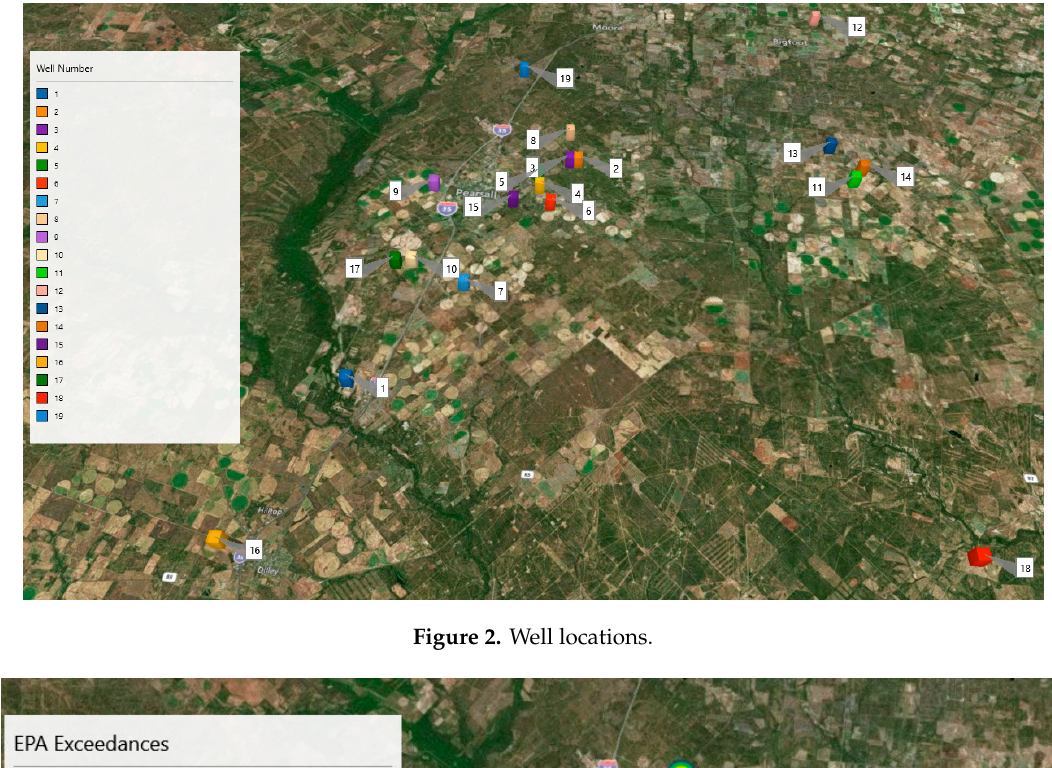
Figure 2. Well locations.